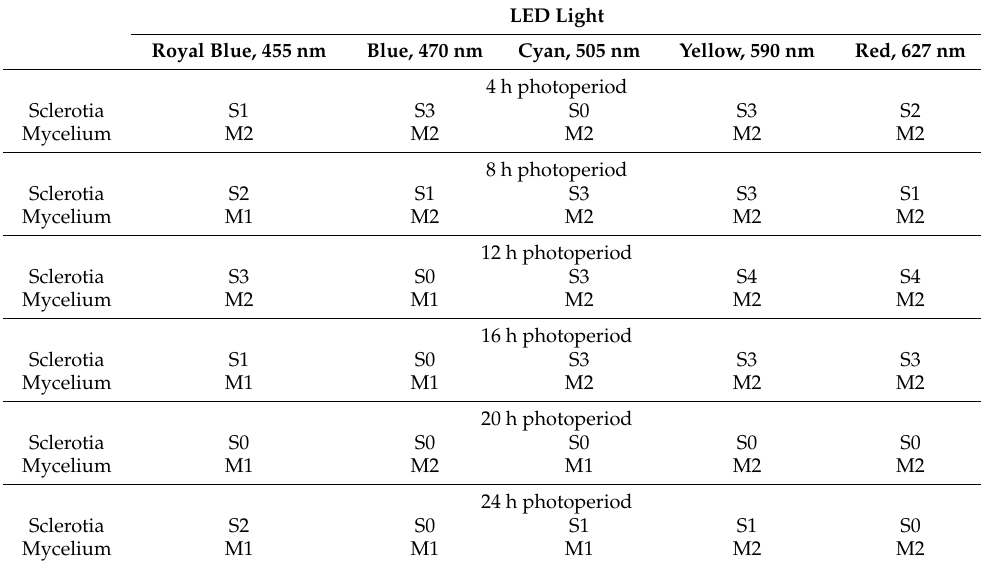
Table 3. The phenotypic classification of Botrytis cinerea after illumination by various LED light wavelengths and